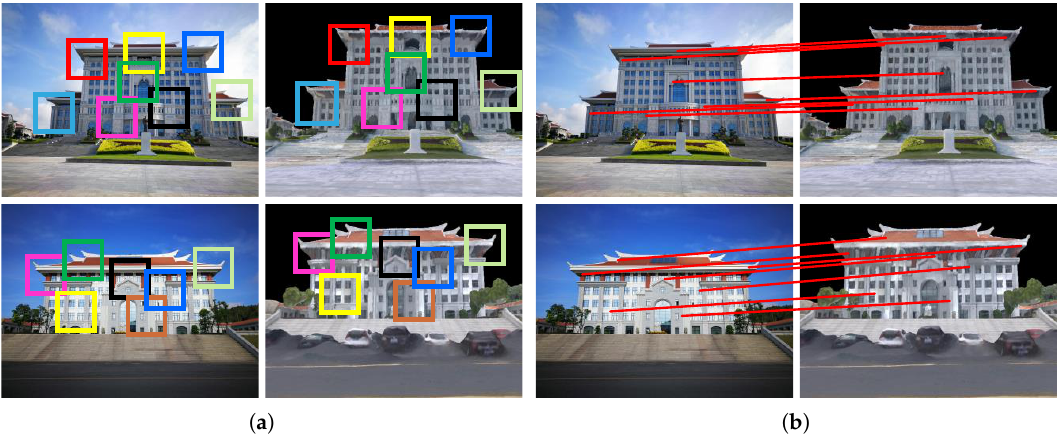
Figure 14. Cross-domain image patch matching results and center point connection of matching image patches. Left: Ground camera images; Right: Rendered images with the same viewpoint of ground camera image. ( a ) Cross-domain image patch matching results. ( b ) Center point connection of the matching image patches in ( a ).